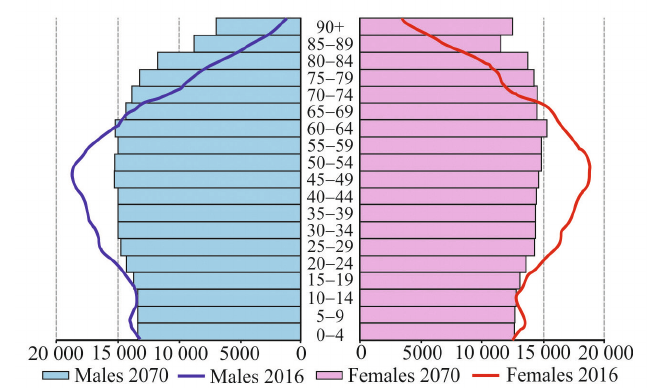
Figure 1. Population by age group and gender for the period